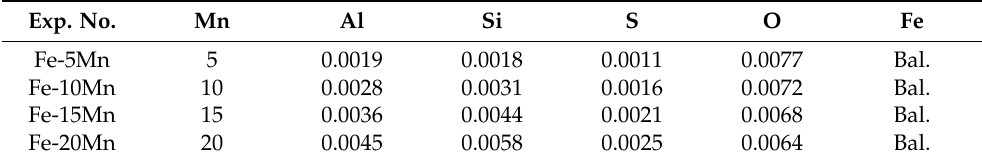
Table 4. Calculated initial chemical composition of steel, mass%. Exp.